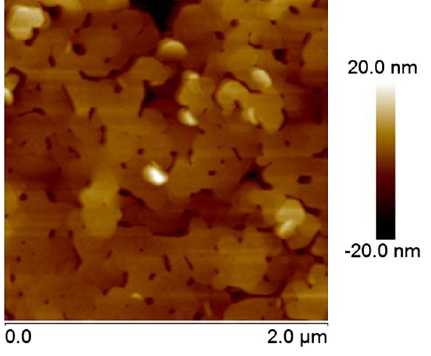
FIG. 5 (color online). AFM image of the MgB 2 film deposited on the Al 2 O 3 substrate mounted at the top location of the stainless steel tube. Interconnected hexagonal grains can be clearly seen.